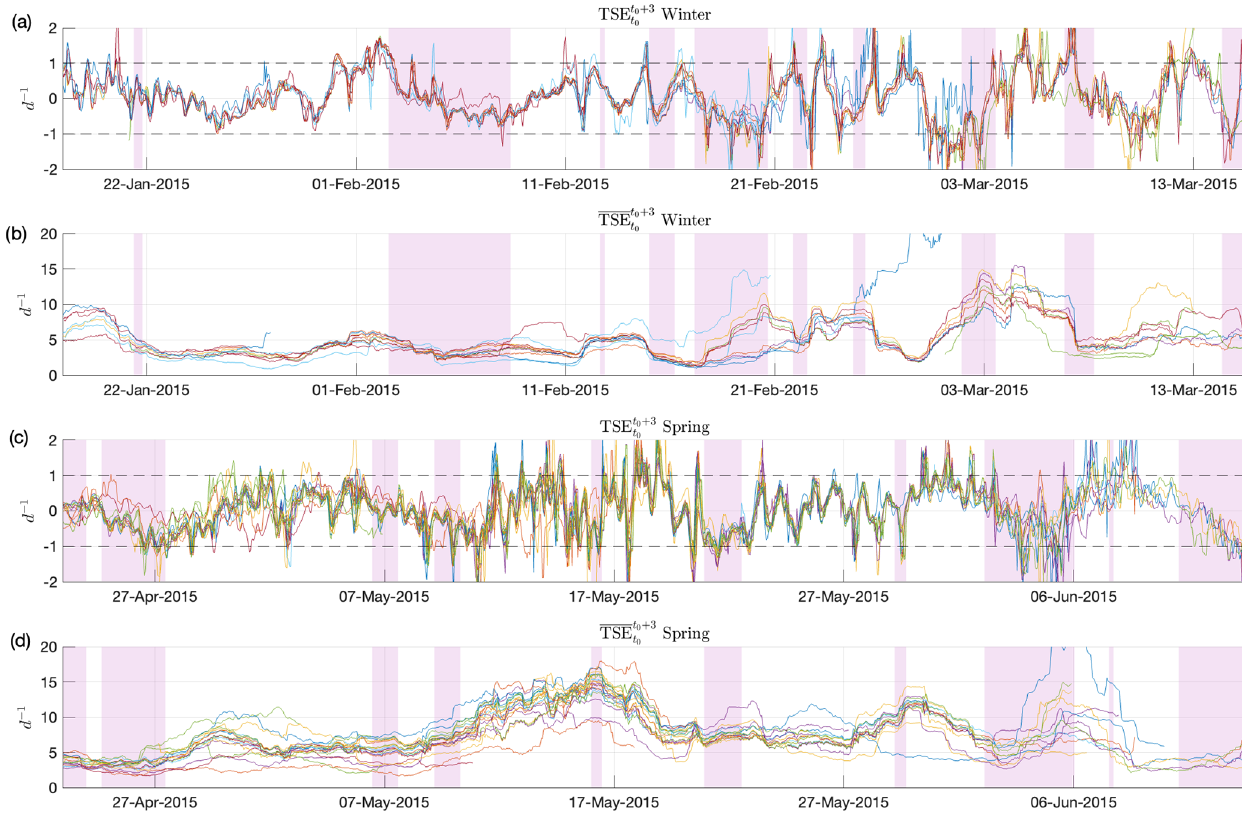
Figure 6. Comparison of TSE and TSE time series for 24 buoys during two stages of the N-ICE2015 experiment. Significant storm events for the winter deployment (a, b) and spring deployment (c, d) are shown as pink regions. A good correlation between strong stretching events and Arctic storms is shown: TSE extrema ( > 1d − 1 , marked by dashed lines) precede all storms and show no false positive sea ice stretching